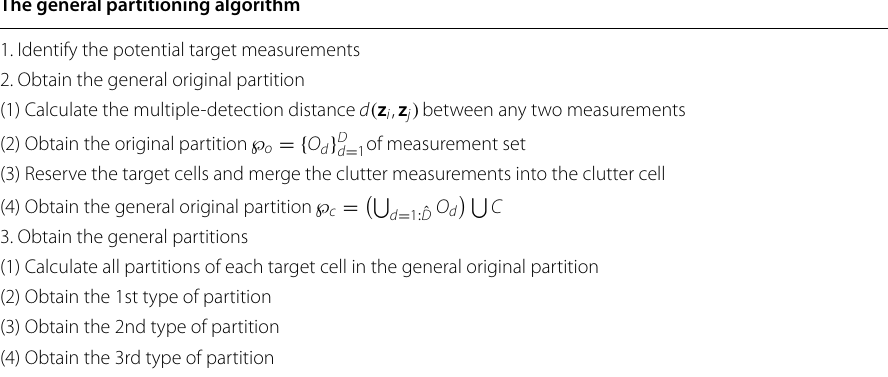
Table 3 Algorithm 3 The general partitioning